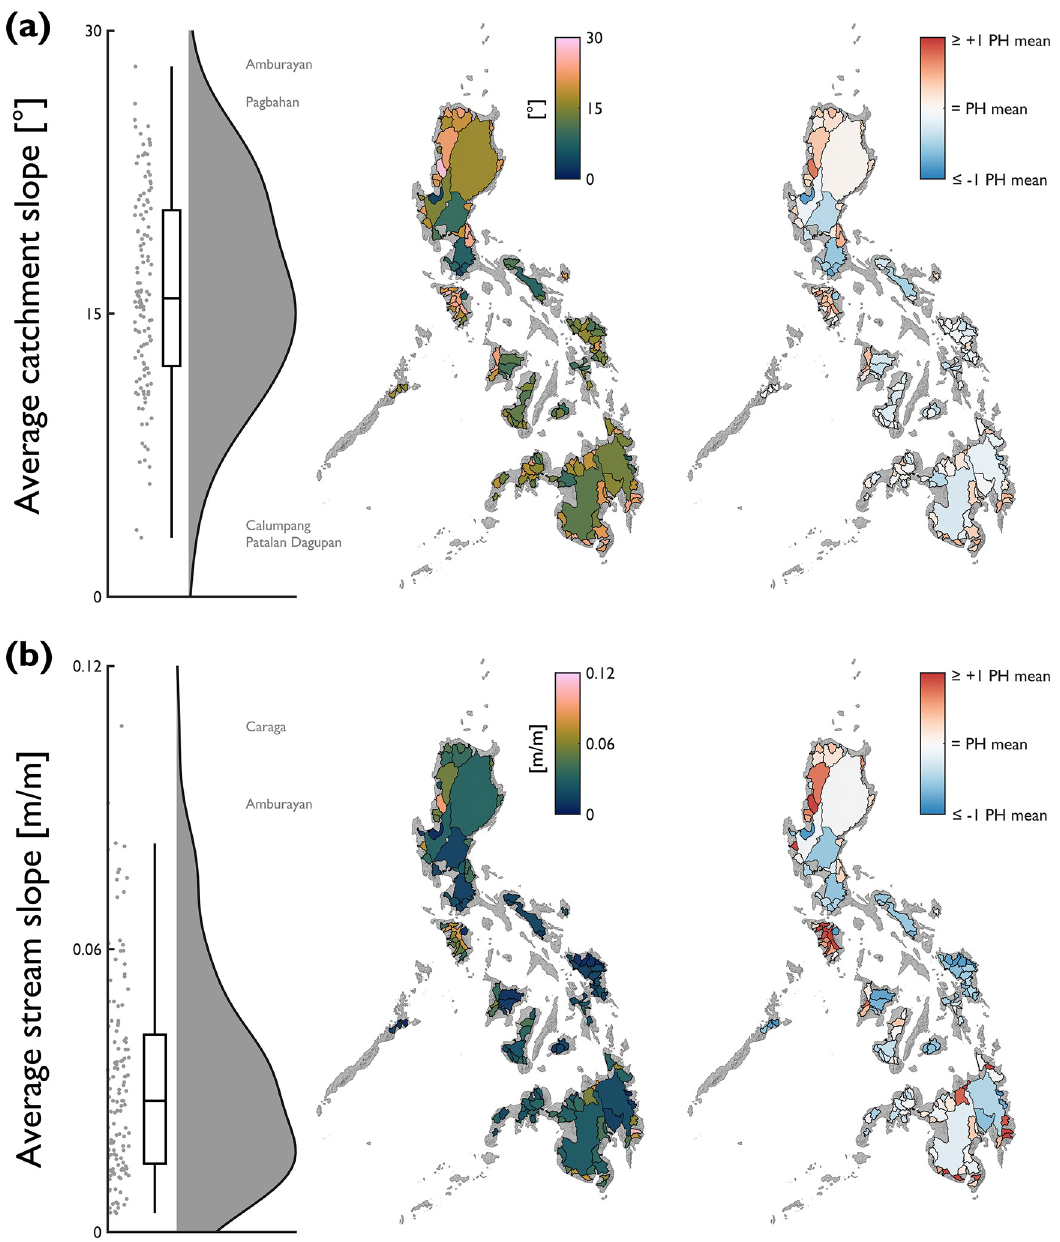
Fig 6. National-scale assessment of slope characteristics, including: (a) average catchment slope; and, (b) average stream slope. Note that for the red-blue choropleth map, values are displayed relative to the Philippine average (average catchment slope = 16.2˚; average stream slope = 0.032 m/m). Annotations on the raincloud plots denote catchments with notably high/low characteristics.